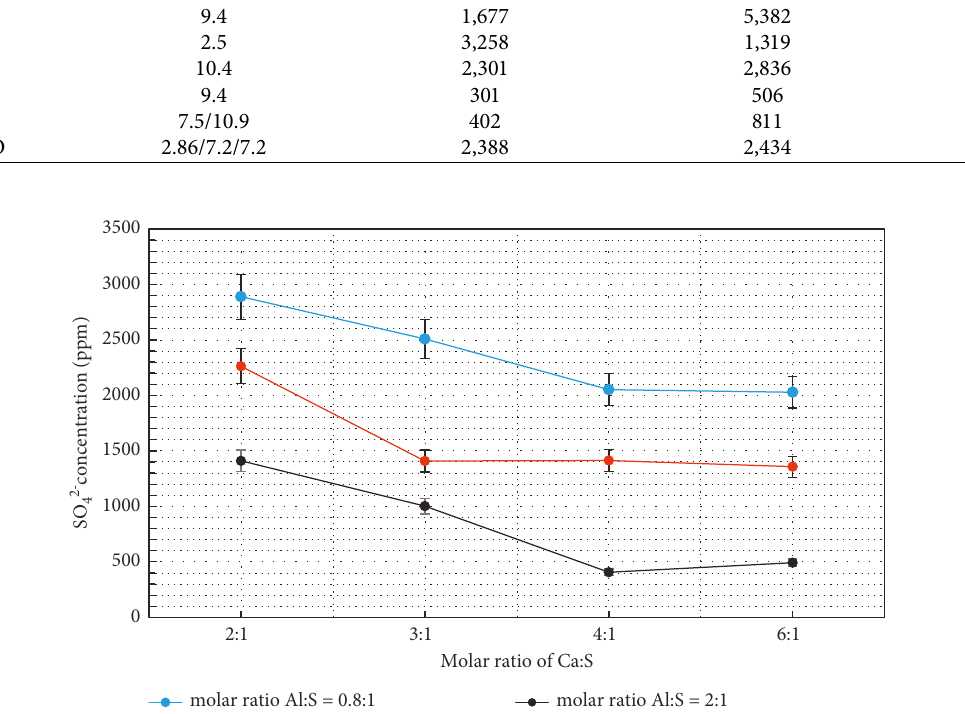
Figure 1: Sulfate concentration in seawater after treatment with various molar ratios of Al : S and Ca:S. The RSD of sulfate concentration is less than